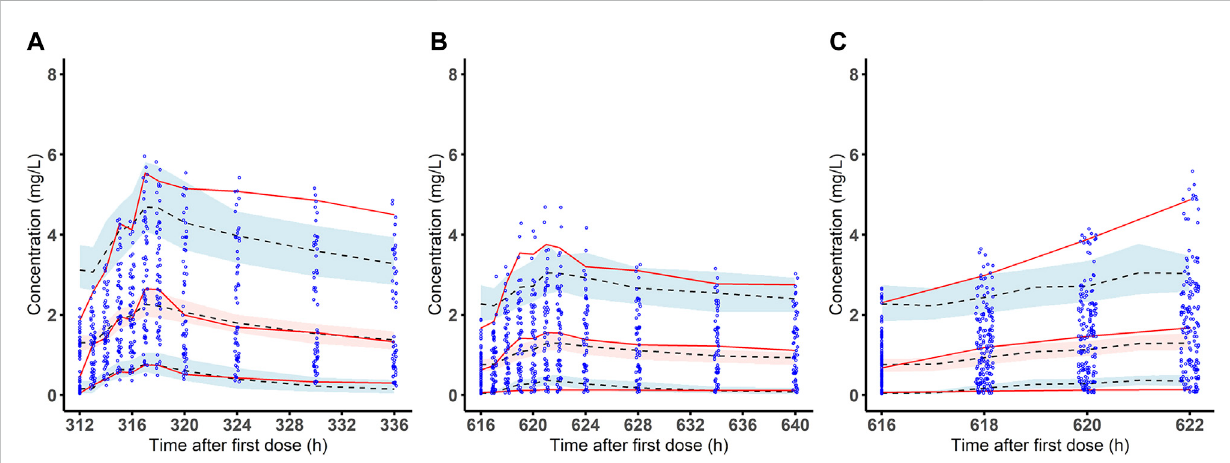
FIGURE 3 Visualpredictivecheckofthe fi nalpopulationpharmacokineticmodelforbedaquiline.Observedbedaquilineconcentration-timedataandthevisual predictive check (VPC) of the fi nal model on week 2 (A) and week 4 (B) of treatment in the development cohort and on week 4 (C) of treatment in the validation cohort. The blue dots are the observed concentrations. The red solid lines are the 50th, 95th and fi fth percentiles of the observed data. The dashed line inthemiddleand thedashed lines on theupper and lowersidesare the50th, 95th and fi fth percentiles of thesimulated concentrations, red and blue shaded areas are their model-predicted 95%